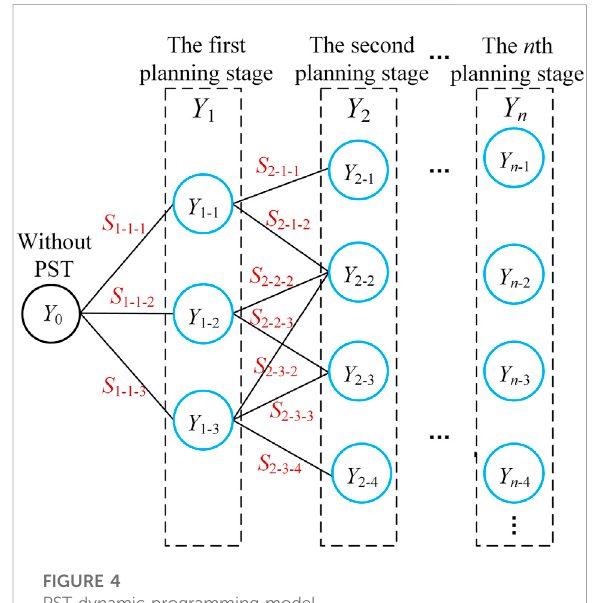
FIGURE 4 PST dynamic programming model.